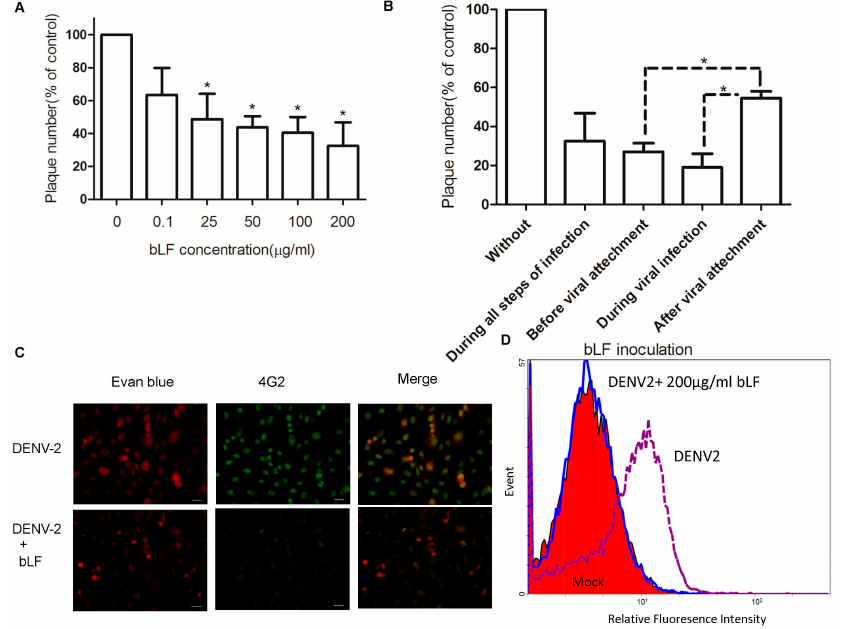
Figure 1. Steps of DENV-2 infection inhibited by bLF. Vero cells were pretreated with various concentrations of bLF (0, 0.1, 25, 50, 100, 200 µ g/mL), then lactoferrin (LF)-treated cells were infected with DENV-2 and bLF mixture for 1.5 h at 37 ◦ C. Subsequently, the cells in each well were overlaid with 4 mL of Dulbecco’s Modified Eagle Medium (DMEM) containing methyl cellulose supplemented with various concentrations of bLF and incubated for 7 days at 37 ◦ C. The plaque number was counted and compared with the virus control (* p < 0.05). Data are mean ± SD of three duplicates. ( A ) In order to determine the steps of DENV-2 infection inhibited by bLF, 200 µ g/mL bLF was added at different stages of virus infection, including during all steps of infection, before viral attachment (pre-treatment), during viral infection (co-treatment), and after viral attachment (post-attachment, DENV-2-bound cells were incubated with bLF for 1 h at 37 ◦ C); and plaque number was counted and compared (* p < 0.05); ( B ) To examine whether bLF inhibits DENV-2 binding to the cellular membrane. Vero cell monolayers were treated with 200 µ g/mL bLF at 4 ◦ C for 1 h, then incubated with DENV-2 at an MOI of 5 at 4 ◦ C for 1 h. After three washes with ice-cold phosphate-buffered saline (PBS), the cells were incubated at 37 ◦ C for 48 h, and then analyzed by immunofluorescence assay (IFA); ( C ) The bLF-treated cells incubated with DENV-2 at a multiplicity of infection (MOI) of 50 at 4 ◦ C for 1 h, fixed immediately after three washes with ice-cold PBS, and then analyzed by flow cytometry; scale bar: 100 µ m ( D ) Using 4G2 MAb and HRP-conjugated goat anti-mouse antibody.